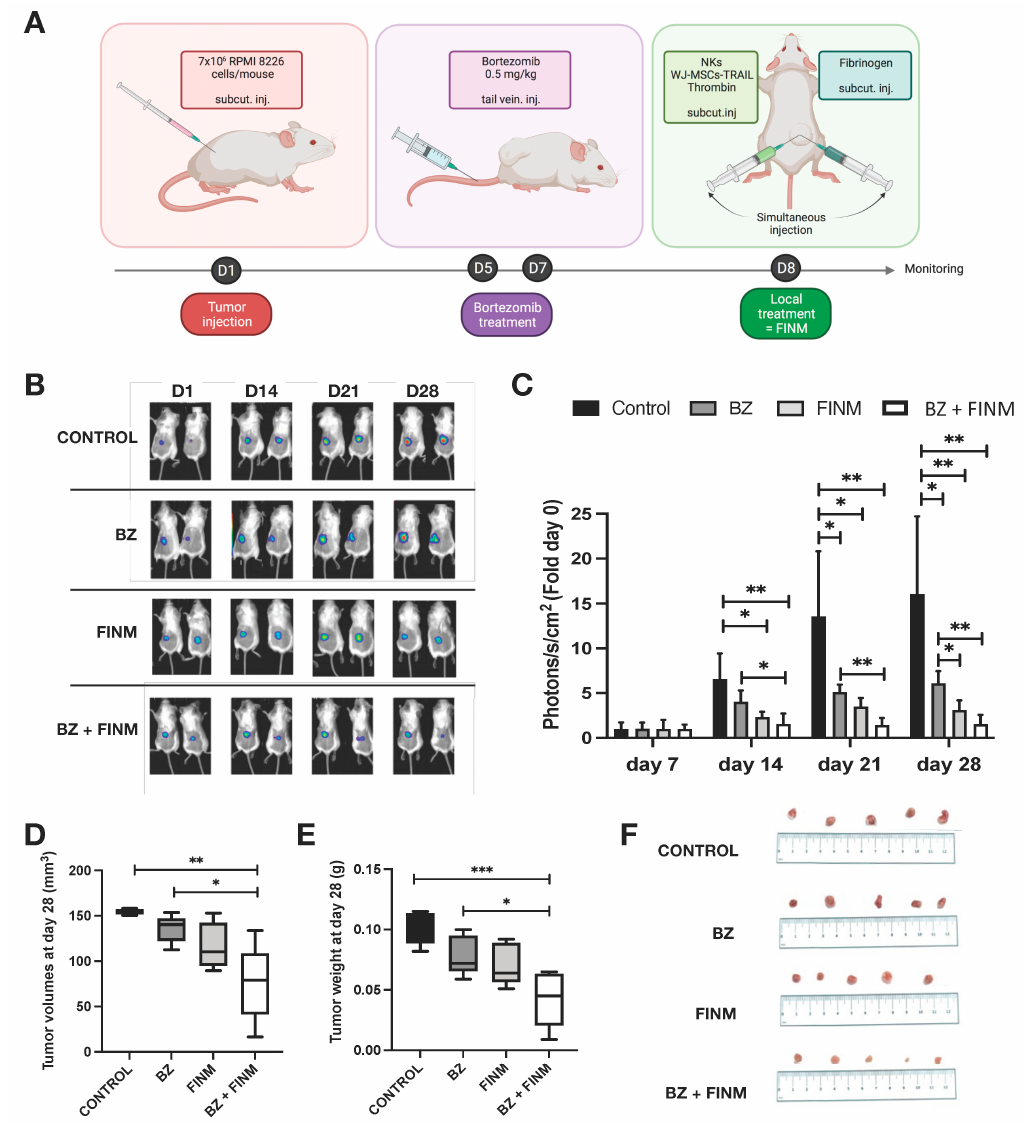
Figure 5. FINM efficiency in in vivo mouse model. ( A ) Schematic description of the experiment including RPMI 8226 cells inoculation, Bortezomib treatment (BZ) and local treatment with FINM prototype expressing TRAIL (FINM). ( B ) Representative bioluminescence images in each group at D7, D14, D21 and D28 after RPMI 8226 cell inoculation (D1). ( C ) Tumor bioluminescence (photon flux) at D7, D14, D21 and D28 after inoculation. ( D ) Tumor volumes in different treatment groups at D28. ( E ) Tumor weights in different treatment groups at D28. ( F ) Image of the tumors retrieved in each group at D28. Data in ( C – E ) are presented as means ± SD from three technical replicates. Ns—not significant; * − p < 0.01; ** − p < 0.005; *** − p < 0.001; one-way ANOVA, repeated measures test and Student’s t